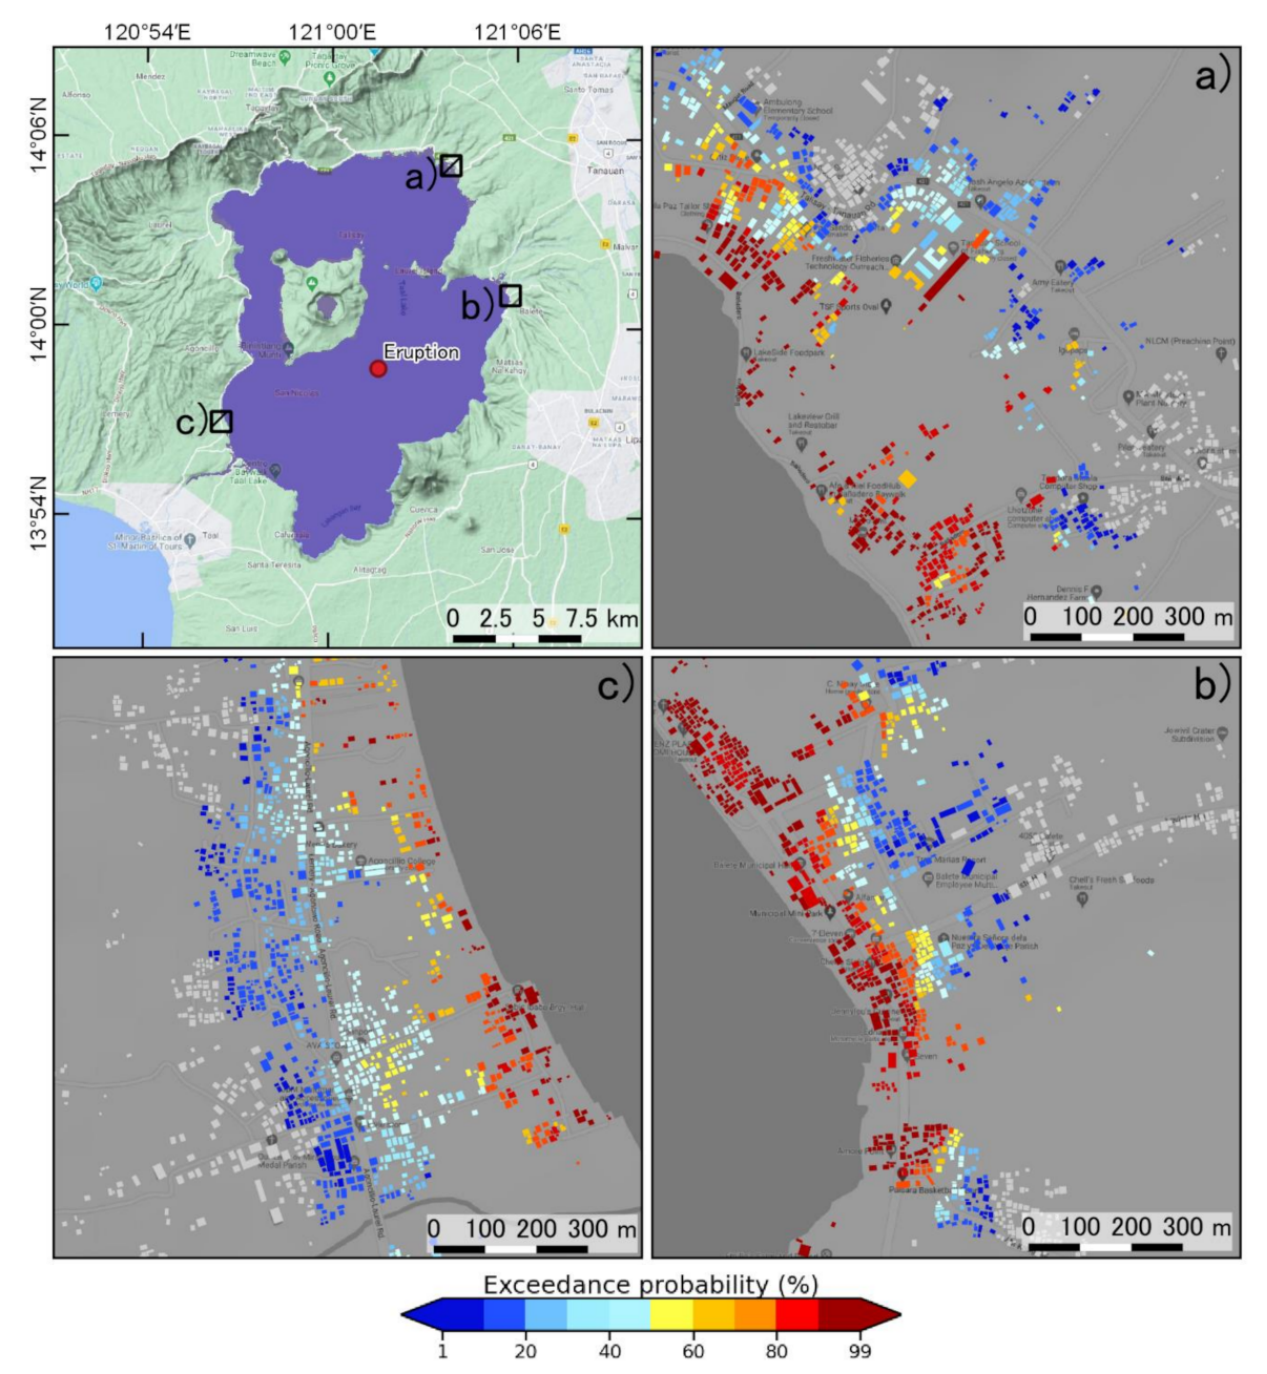
Figure 13. Probability of experiencing a tsunami inundation depth of more than 1.5 m in some example areas. ( a ) northern coastal area, ( b ) coastal area near to the eruption point, and ( c ) southern coastal